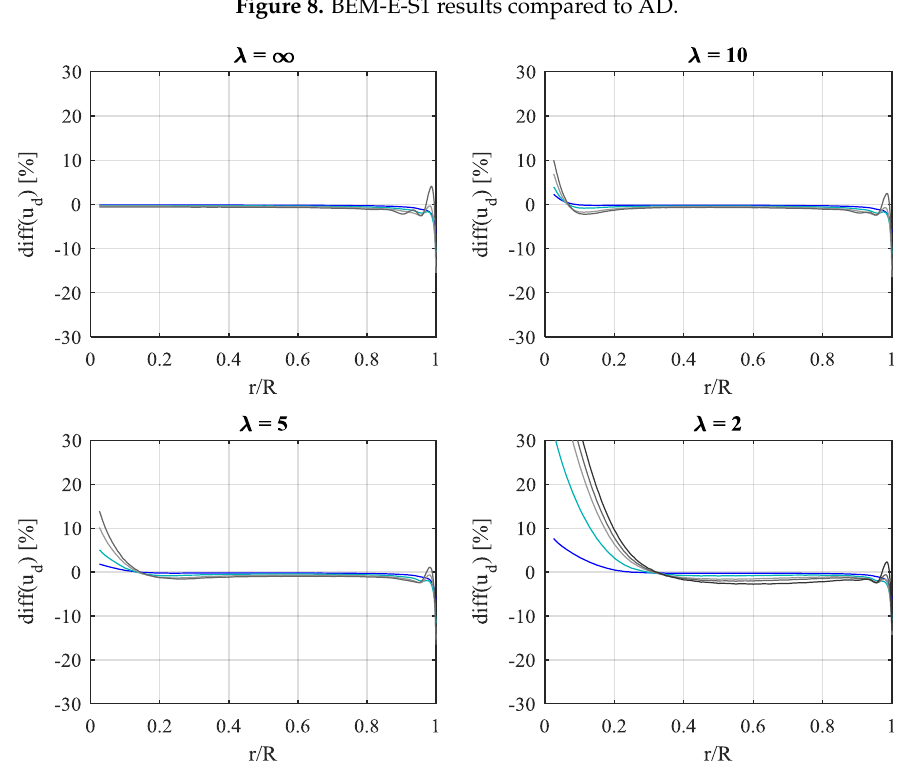
Figure 9. BEM-E-S2 results compared to AD.